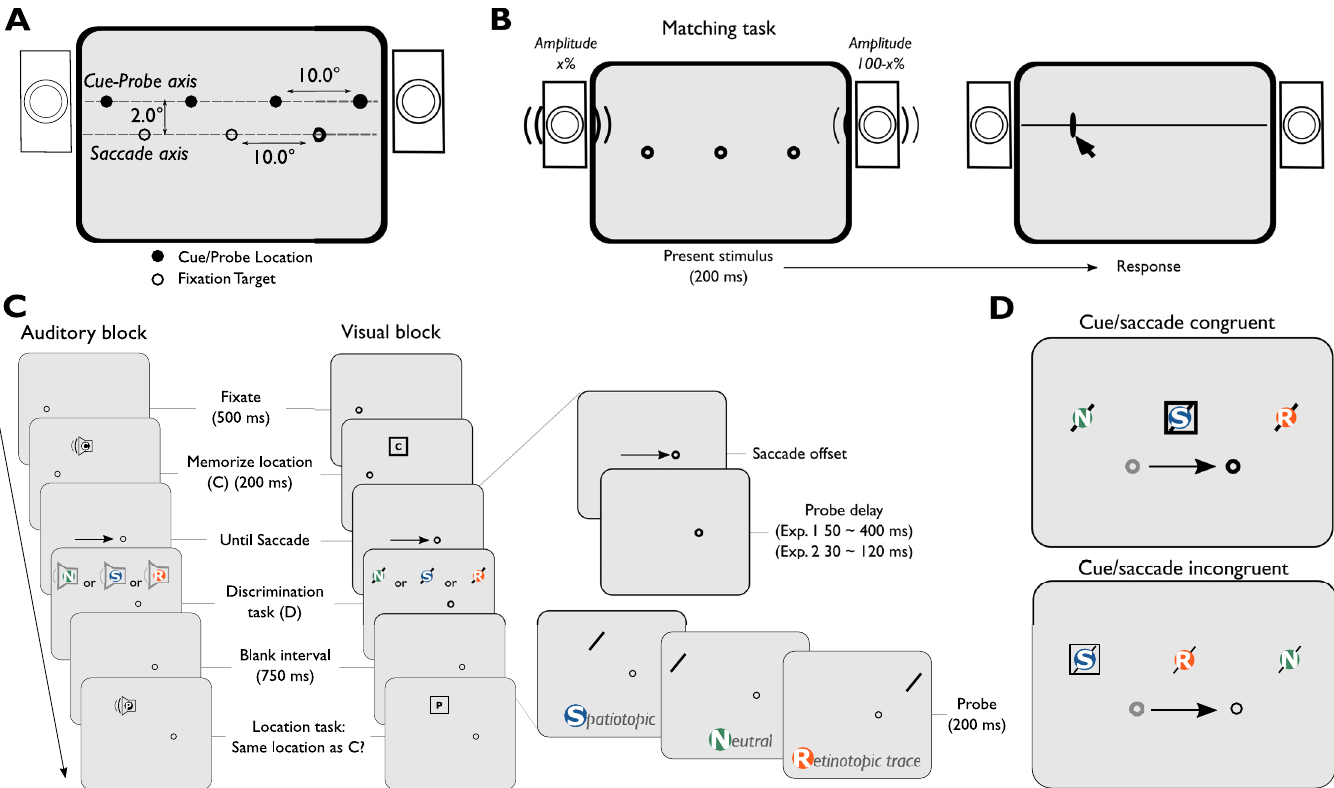
Fig 1. Experimental procedure for Experiment 1 and 2. A) An illustration of the set-up. Stimuli could appear on two axes on the screen. Fixation targets were presented on the bottom axis, cues and probes on the upper axis. B) A trial in the matching task. White noise was presented for 200 ms, participants clicked where they heard the sound originating from. C) Experimental procedure during the auditory and visual blocks. The discrimination task portion of the trial is shown in further detail on the right. There were different probe locations and probe delays. D) An example of congruent and incongruent probe and memory locations with respect to saccade direction. Square = visual cue location, diagonal line = visual probe